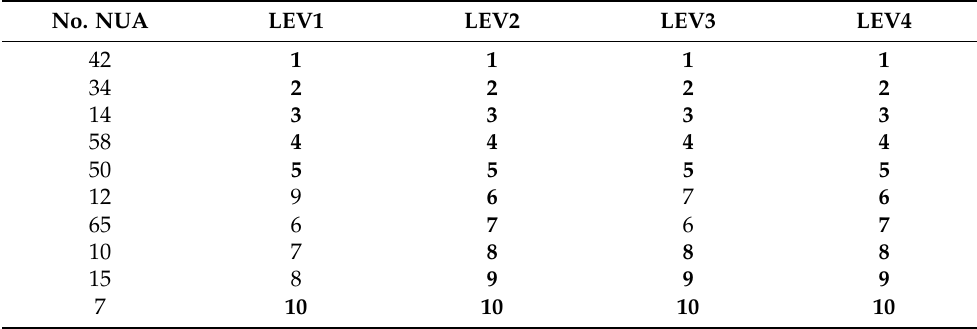
Table 7. NUA ranking in terms of the ESV. The bold value represents the NUAs rank that shows the correspondence between the scenarios (LEV1, LEV2, LEV3) and the